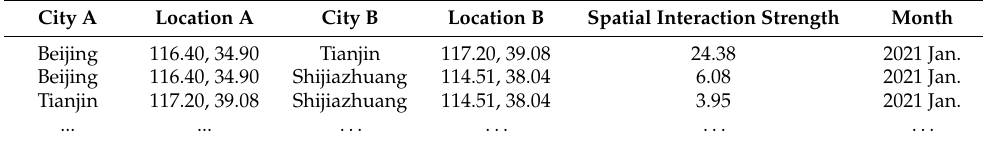
Table 1. The city nodes table of the sample